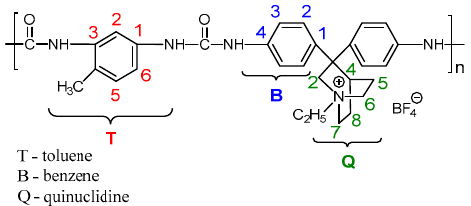
Scheme 7. Structure of PUR1.BF 4 and its NMR